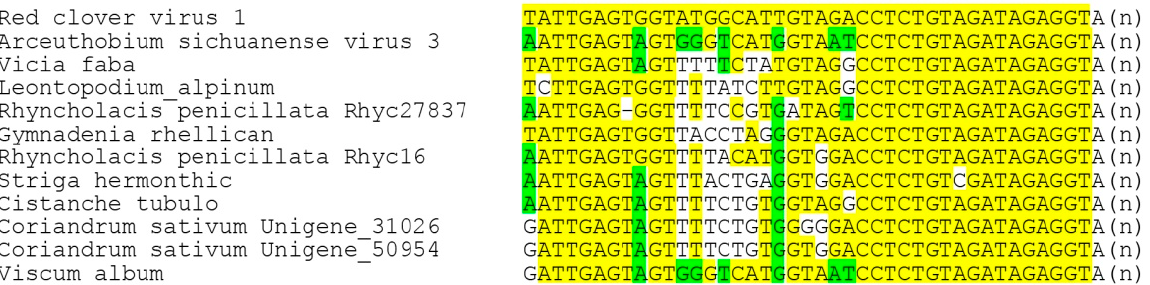
Figure 7. Multiple nucleotide sequence alignment of the 3 ′ -terminal regions preceding poly(A) in the predicted VLRA RNAs of reclovirids. Conserved nucleotides and RNA blocks are highlighted by yellow background. Residues identical to Arceuthobium sichuanense virus 3 are shown in green. A(n) at the 3’-terminus means poly(A) tract. Truncated VLRAs that are not shown in phylogenetic subtree include Vicia faba VLRA (GISP01006645) and Cistanche tubulosa VLRA (GJRS01079843).